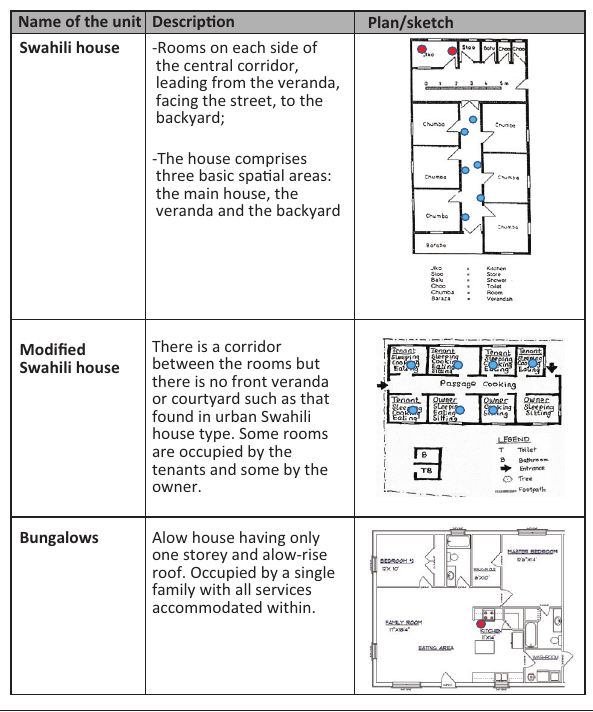
FIGURE 6: House types found in